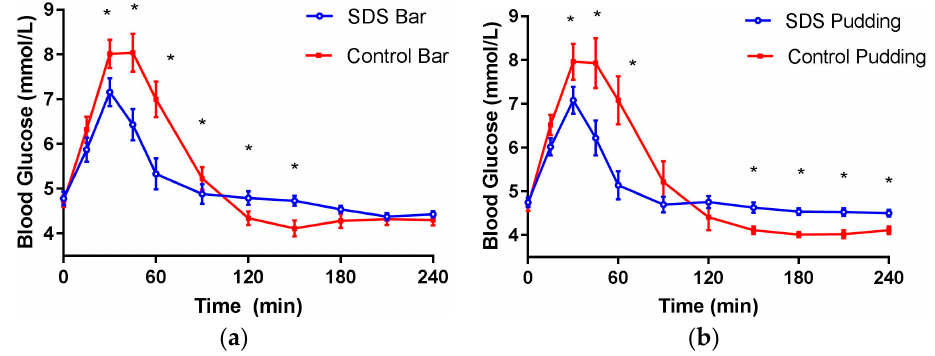
Figure 3. Post-prandial glycemic response of SDS in healthy adults ( a ) cold-pressed bars ( b ) instant pudding. Data are mean ± standard error mean (SEM); * indicates treatments were significantly different at specific time points in the paired t -test ( p < 0.05).